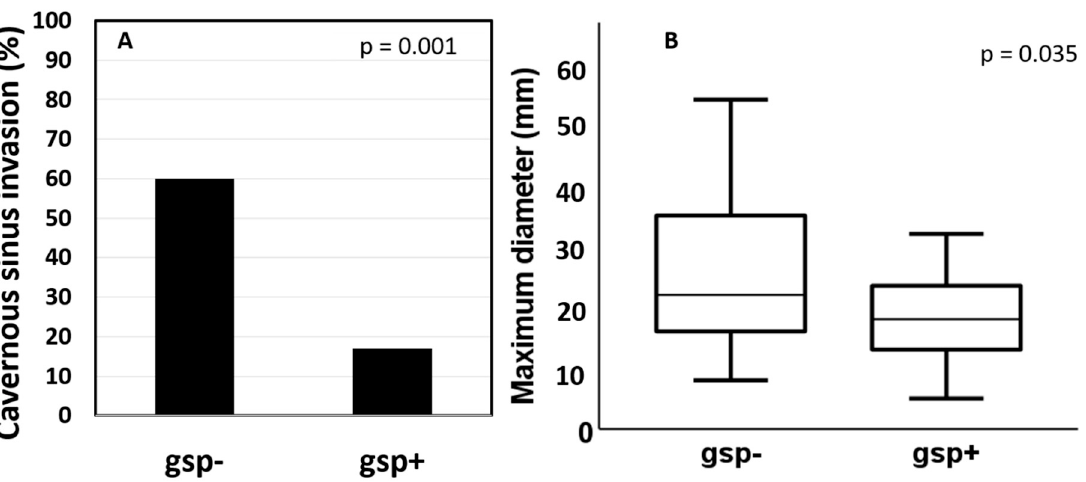
Figure 2. Association between gsp mutation and cavernous sinus invasion ( A ) and tumor maximum diameter ( B ). One outlier from the gsp + group was excluded from the graph for better visualization: 42 mm.